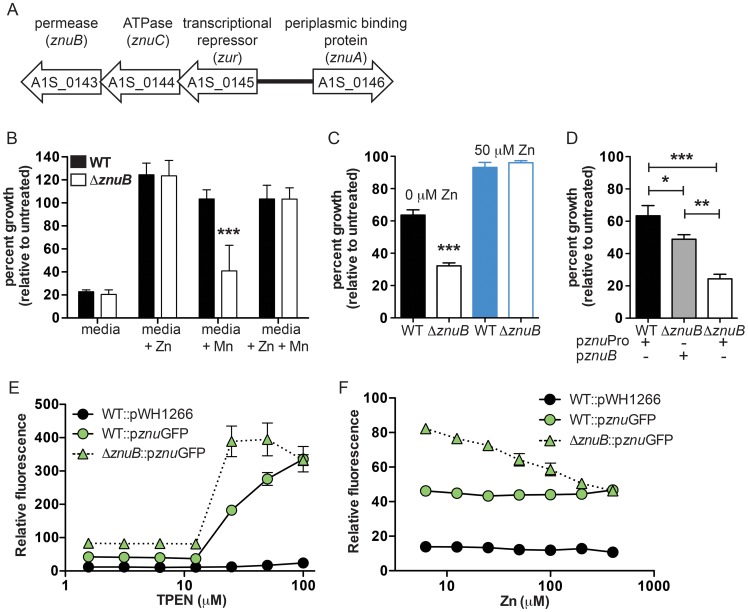
Contribution of znuB to growth in Zn-limiting conditions.(A) Schematic representation of the genomic context adjacent to A1S_0143. (B) CP growth inhibition assays comparing wildtype with ΔznuB. Bacteria were cultured in CP growth media in the presence of increasing concentrations of CP with or without addition of 25 µM Zn, 25 µM Mn or both 25 µM Zn and 25 µM Mn. Data for 100 µg/ml CP are presented as the percent growth relative to bacterial growth without CP. Data are the average of three independent experiments with at least three biological replicates each. (C) Comparison of the effect of 25 µM TPEN on inhibition of wildtype and ΔznuB with or without addition of excess (50 µM) Zn. (D) Complementation of the sensitivity of ΔznuB to 20 µM TPEN by providing a wildtype copy of znuB in trans. Data are representative of three independent experiments with at least three biological replicates in each. * p<0.05, ** p<0.01, *** p<0.001 as determined by one-way ANOVA. (E–F) Assessment of znu promoter activity in the presence of increasing concentrations of TPEN (E) or Zn (F) using a GFP reporter. GFP activity is expressed as relative fluorescence where the intensity of the signal is normalized to the optical density of the culture.